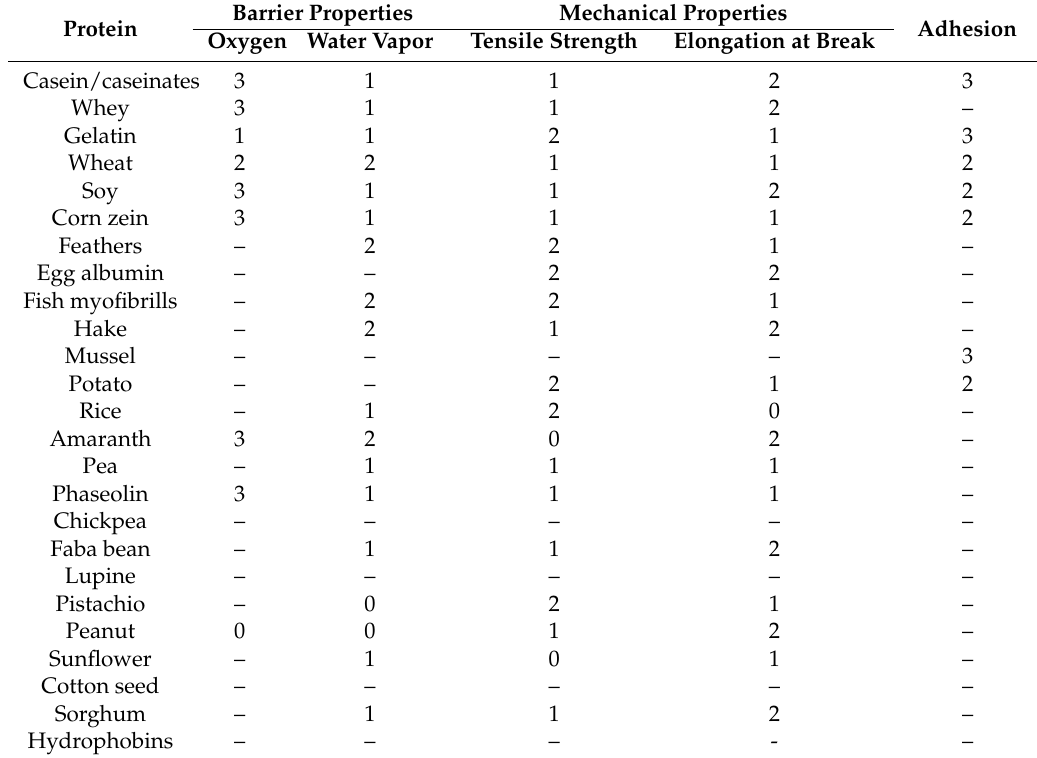
Table 4. Comparative table for protein films